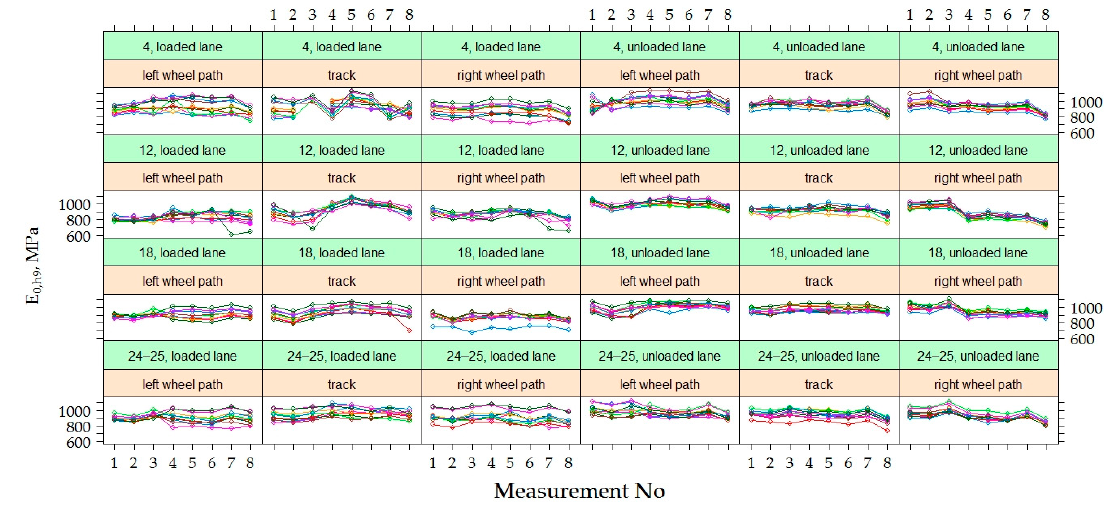
Figure 18. The dynamic of the individual E 0,h9 values of each section for each point of measurement on the right and left wheel paths and in the loaded and unloaded lanes.